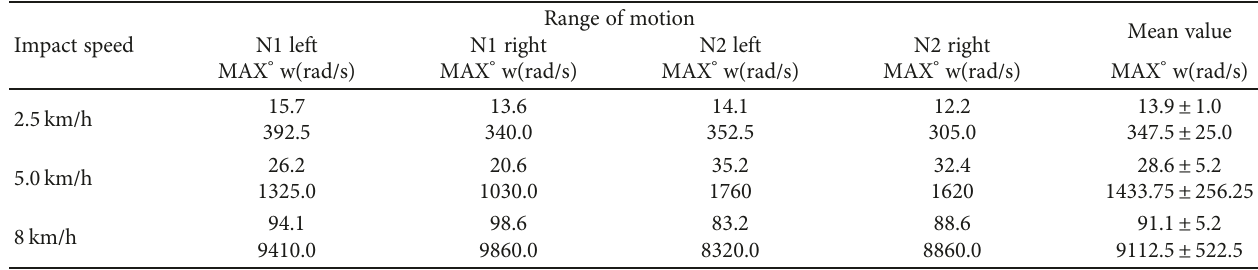
Table 2: Angle changes in knees at di ff erent